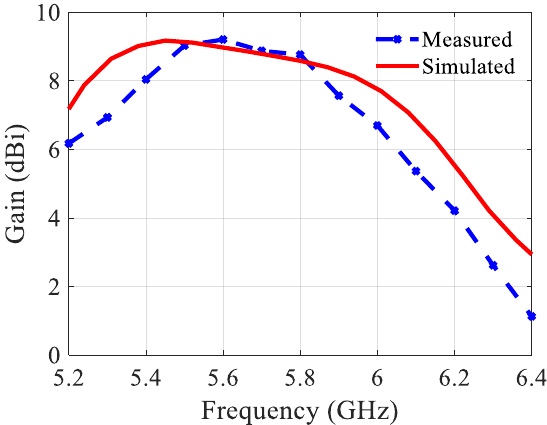
Figure 10. Gain of the 2 × 1 building block with an air layer.